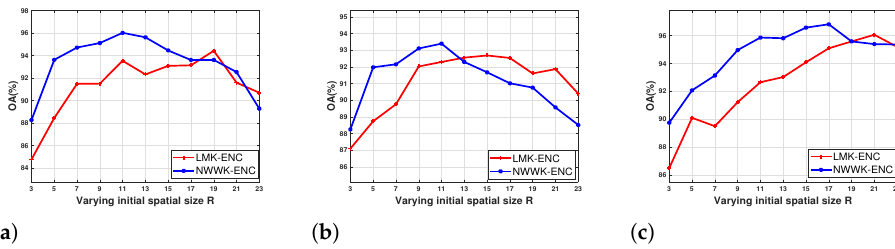
Figure 6. Impact of the superpixel size R for ( a ) Flevoland dataset, ( b ) Yihechang dataset, and ( c ) San Francisco dataset.